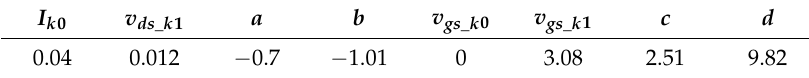
Table 1. The extracted I–V kink effect model parameters in Equations (1) and